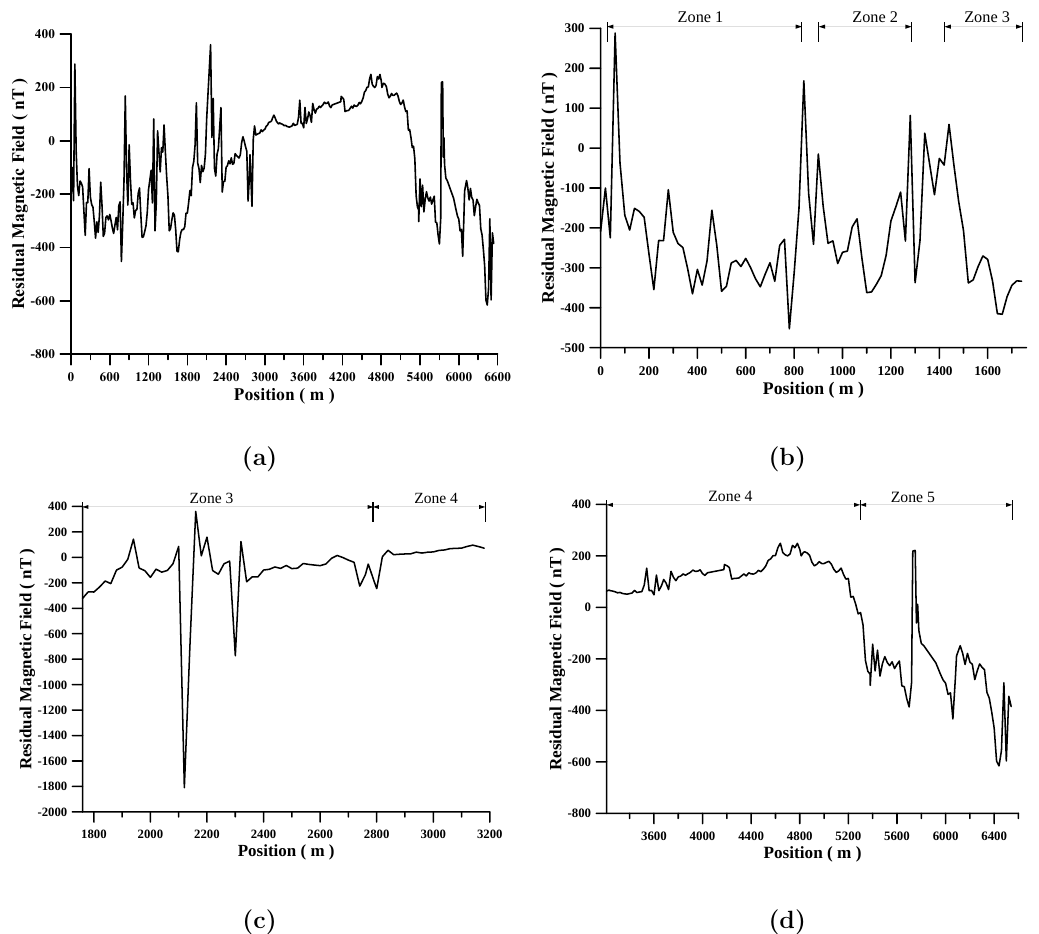
Figure 2. Variation of the residual magnetic values along the NNW-SSE profile – observed value subtracted of the ambient field: (a) for the entire profile after exclusion of anomalous values lower than -700nt; (b) for its northern part; (c) for its central part; (d) for its southern